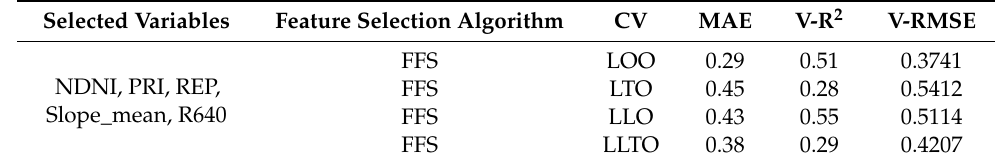
Table 4. RF model of the forage N contents throughout the growth